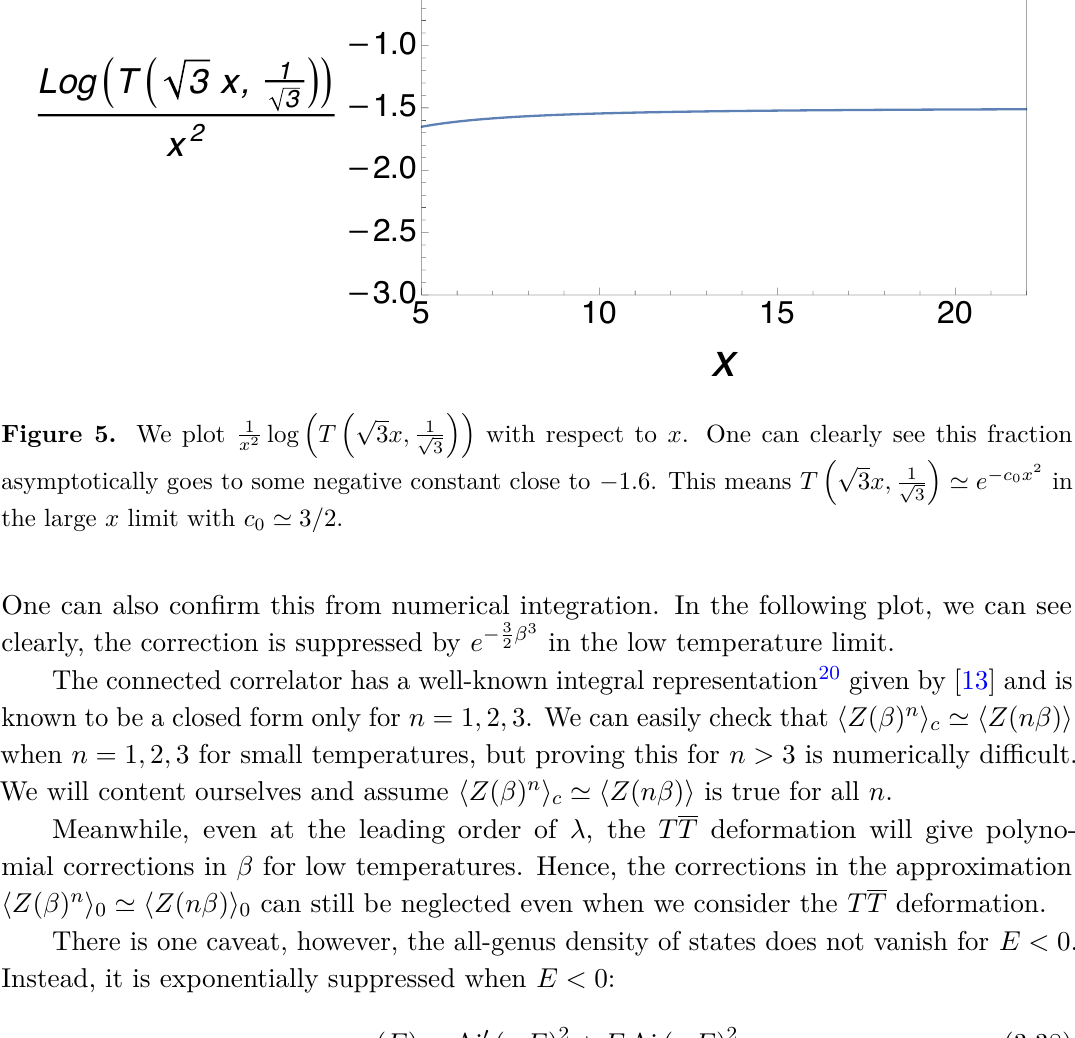
Figure 5. We plot 1 asymptotically goes to some negative constant close to − 1 . 6 . This means T the large x limit with c